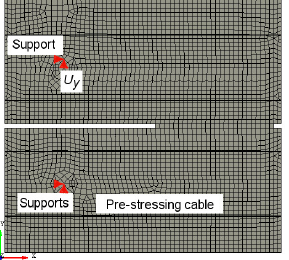
Figure 13. 2D FE mesh composed of approx. 2 . 0 mm by 2 . 0 mm quadrilaterals aligned with the specimen edges.